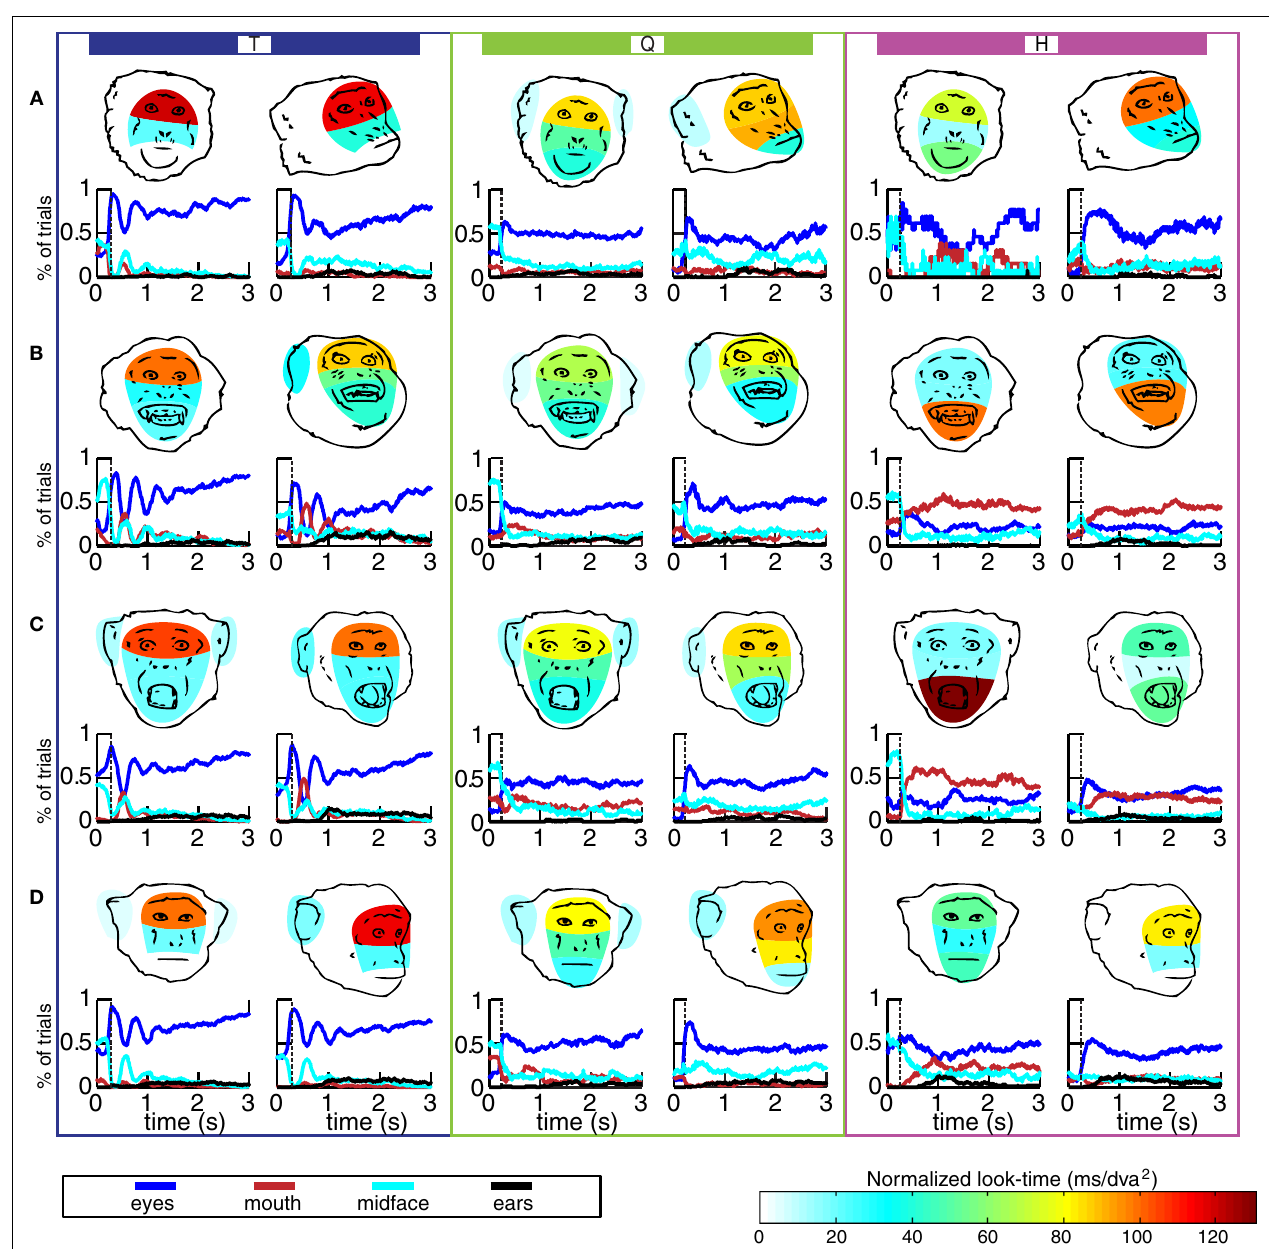
FIGURE 7 | Allocation of visual attention to face regions as a function of facial expression and direction of gaze. The color for each face region represents normalized looking time. Rows (A–D) contain schematic facial expressions of lip-smack, fear-grimace, threat, and neutral, respectively. The plots in the blue, green, and purple rectangles labeled T, Q and H correspond to data from each monkey. The line graphs below each face show the percent of